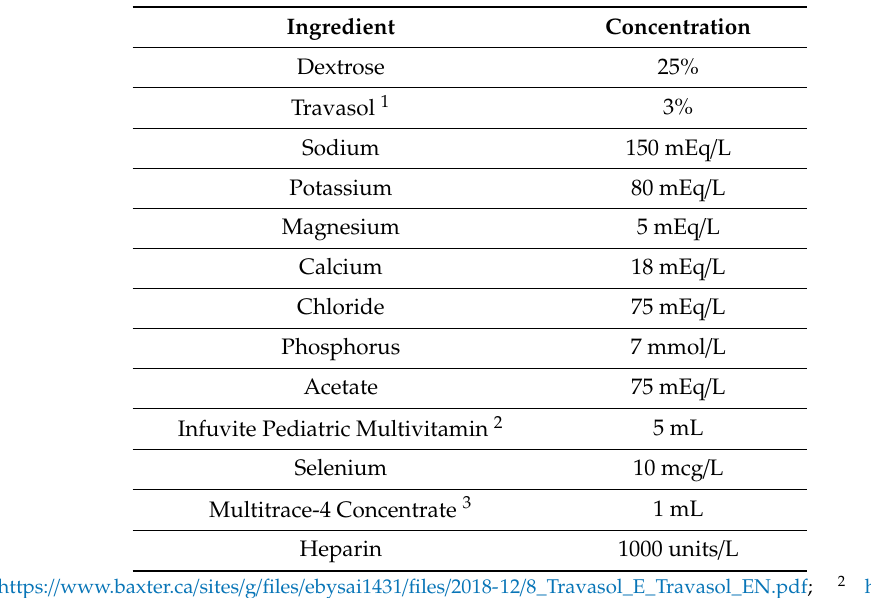
Table 2. Total parenteral nutrition (TPN)